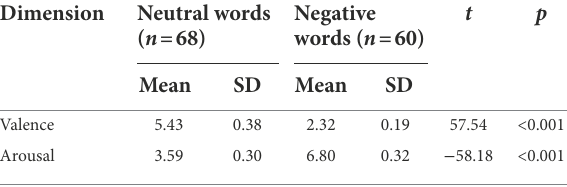
TABLE 1 Mean and SD of valence and arousal ratings for all the words.